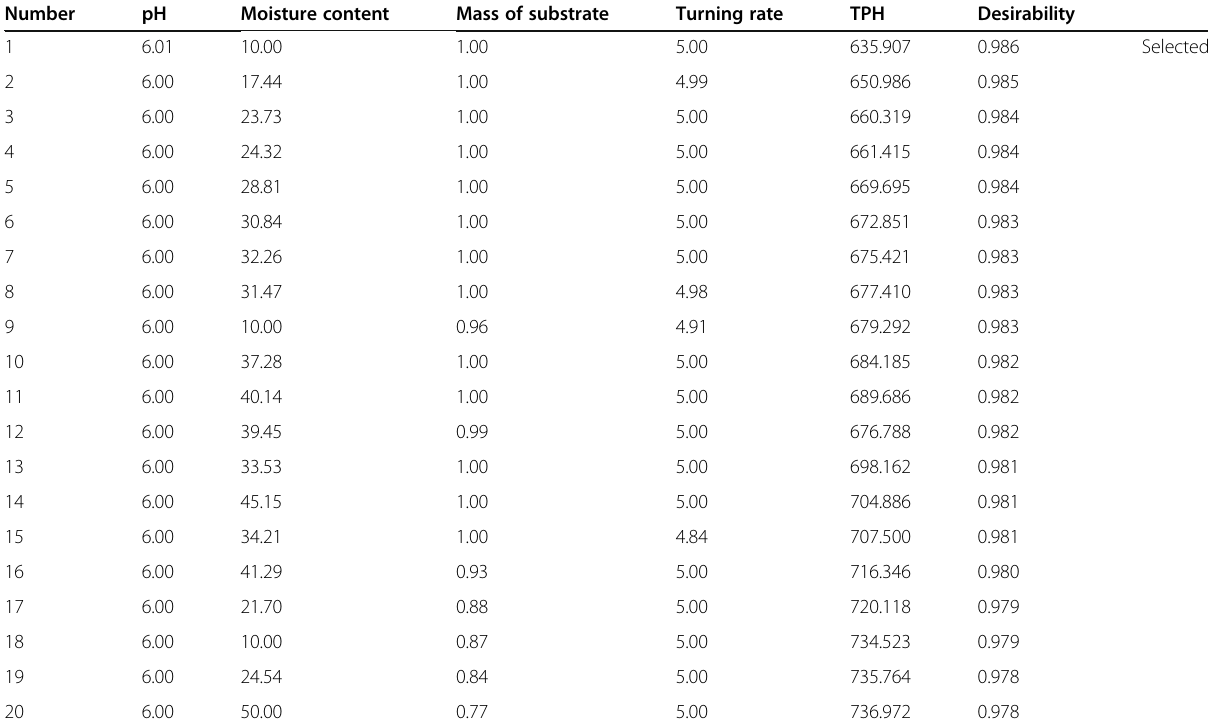
Table 10 Optimal solutions of numerical optimization model